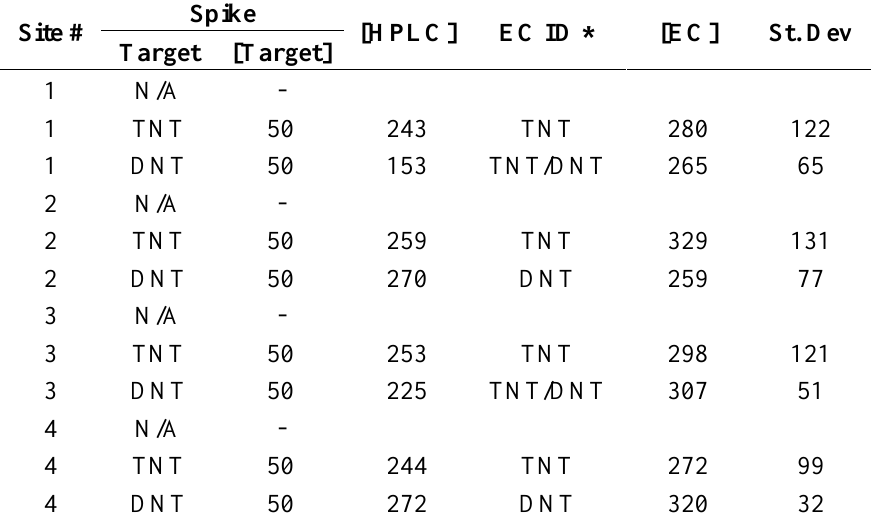
Table 1. Analysis of field samples. 2,4,6-trinitrotoluene (TNT) and dinitrotoluene (DNT) reduction peaks at −0.62 V ±0.02 and −0.77 ± 0.02, respectively. Samples were analyzed in triplicate; concentrations provided in parts per